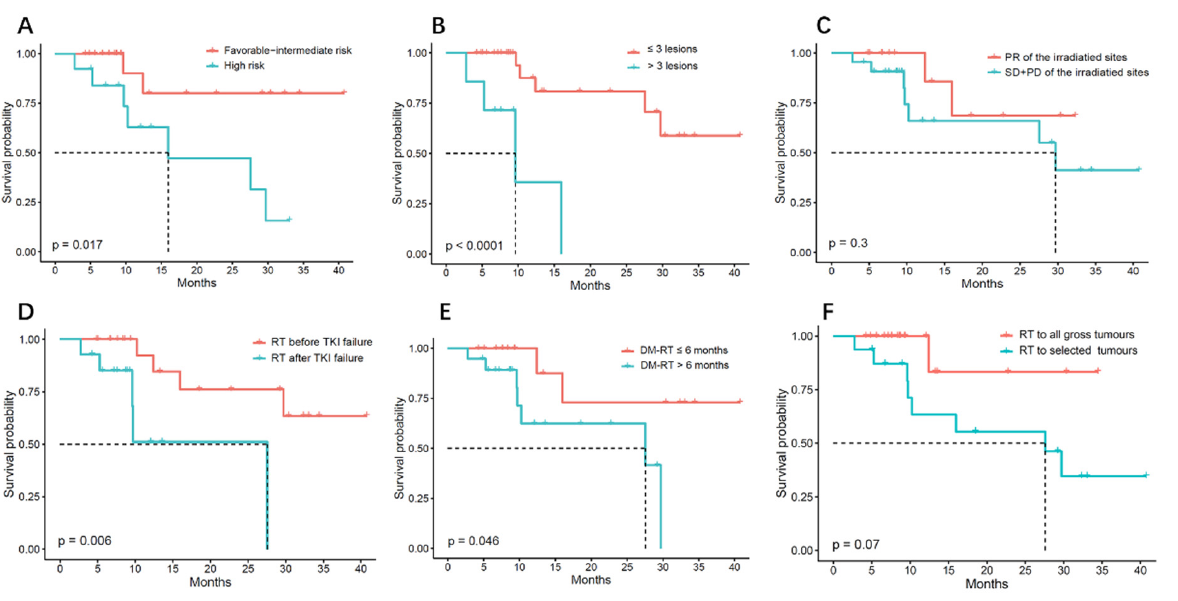
Figure 3. Overall survival rate (OS) of oligometastatic renal cell carcinoma patients ( n = 35) treated with SABR/P-SABR in relation to ( A ) IMDC risk, ( B ) number of metastases, ( C ) response to RT, ( D ) sequencing with TKI, ( E ) time from first metastasis to RT, and ( F ) radiation coverage. Table 3. Toxicities in mRCC patients from stereotactic radiotherapy. Side